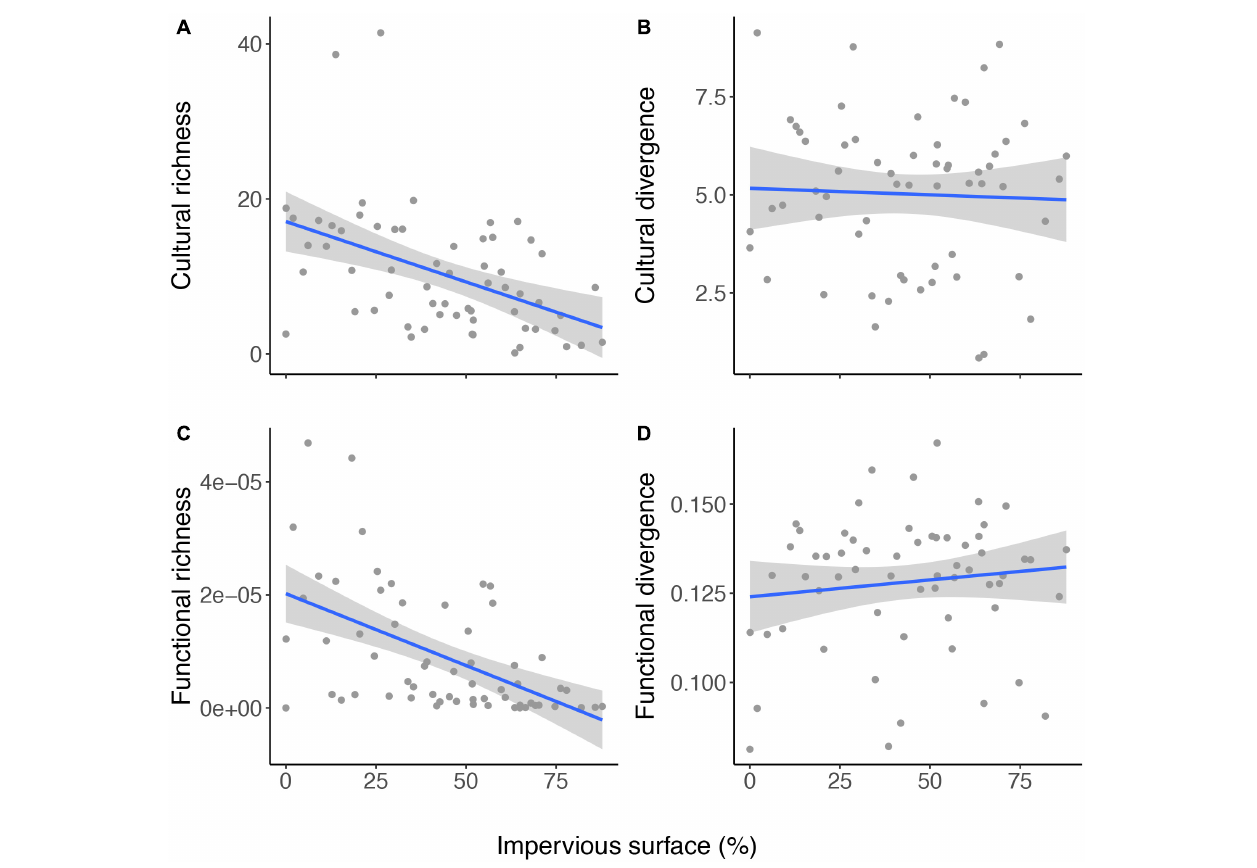
FIGURE 1 | Relationships between the percentage of impervious surface and cultural (A) and functional (B) richness, and cultural (C) and functional (D) divergence for bird sampled in 61 hexagons in Campo Grande, central